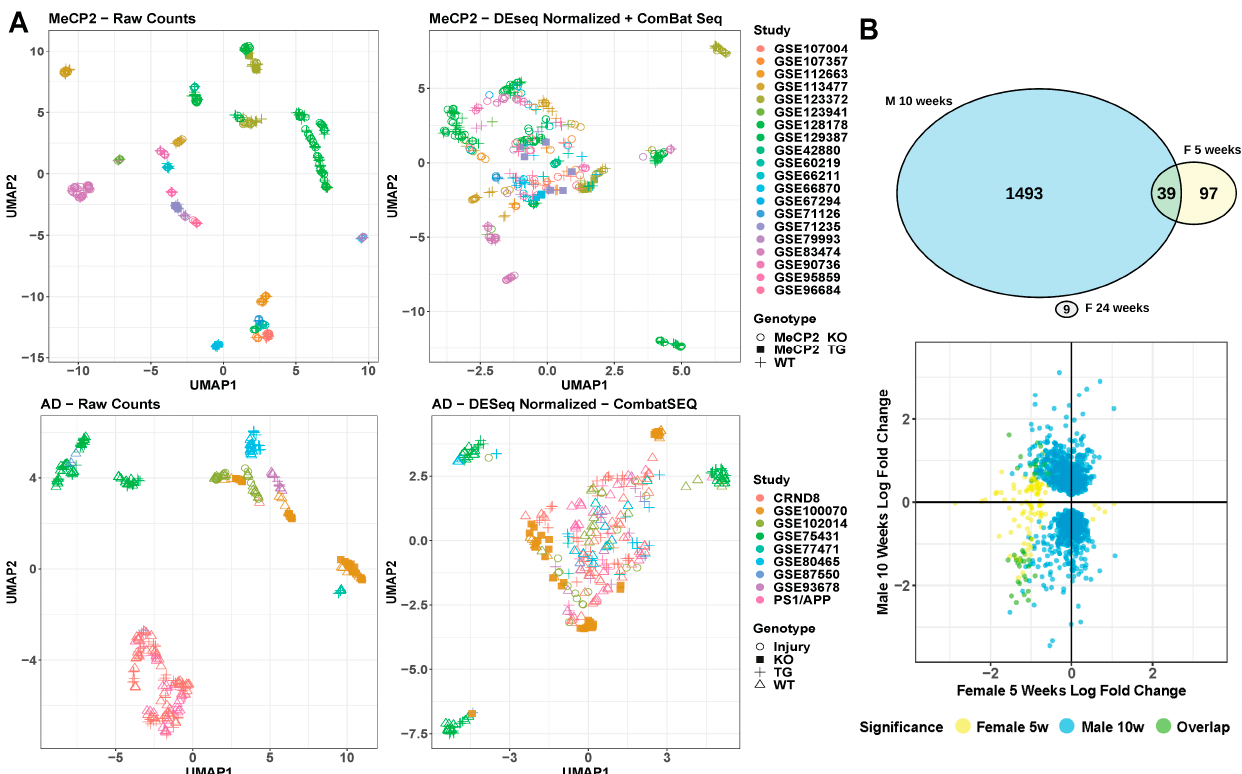
Figure 6. Technical variation/batch effect analysis. ( A ) UMAP visualization of raw and corrected data from MeCP2 and AD. ( B ). Comparison of cell type-matched (microglia), male-to-female contrasts